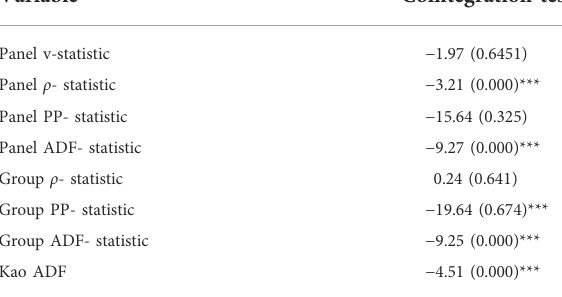
TABLE 3 Panel cointegration